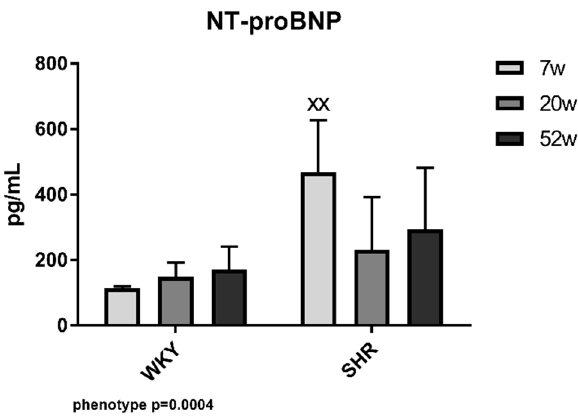
Figure 3. NT-proBNP in WKY and SHR in different age groups. The data are presented as means ± SD. Statistical significance: XX represents p < 0.01 in comparison with age-matched WKY. WKY—Wistar-Kyoto rats, SHR—spontaneously hypertensive rats NT-proBNP—N-terminal pro-brain natriuretic peptide.